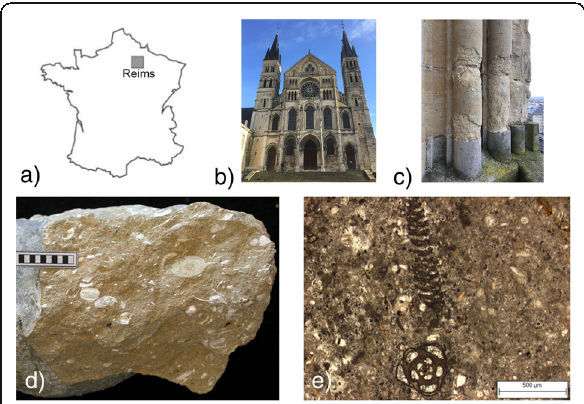
Fig. 1 a Location of Reims (France), b Reims Cathedral built with Lutetian limestone, c weathering patterns on a capillary zone of the Cathedral, d Courville limestone (Lutetian) (G. Fronteau), and e thin section of Courville limestone showing fossils of miliolid and Orbitolites complanatus inside a micrite (G.